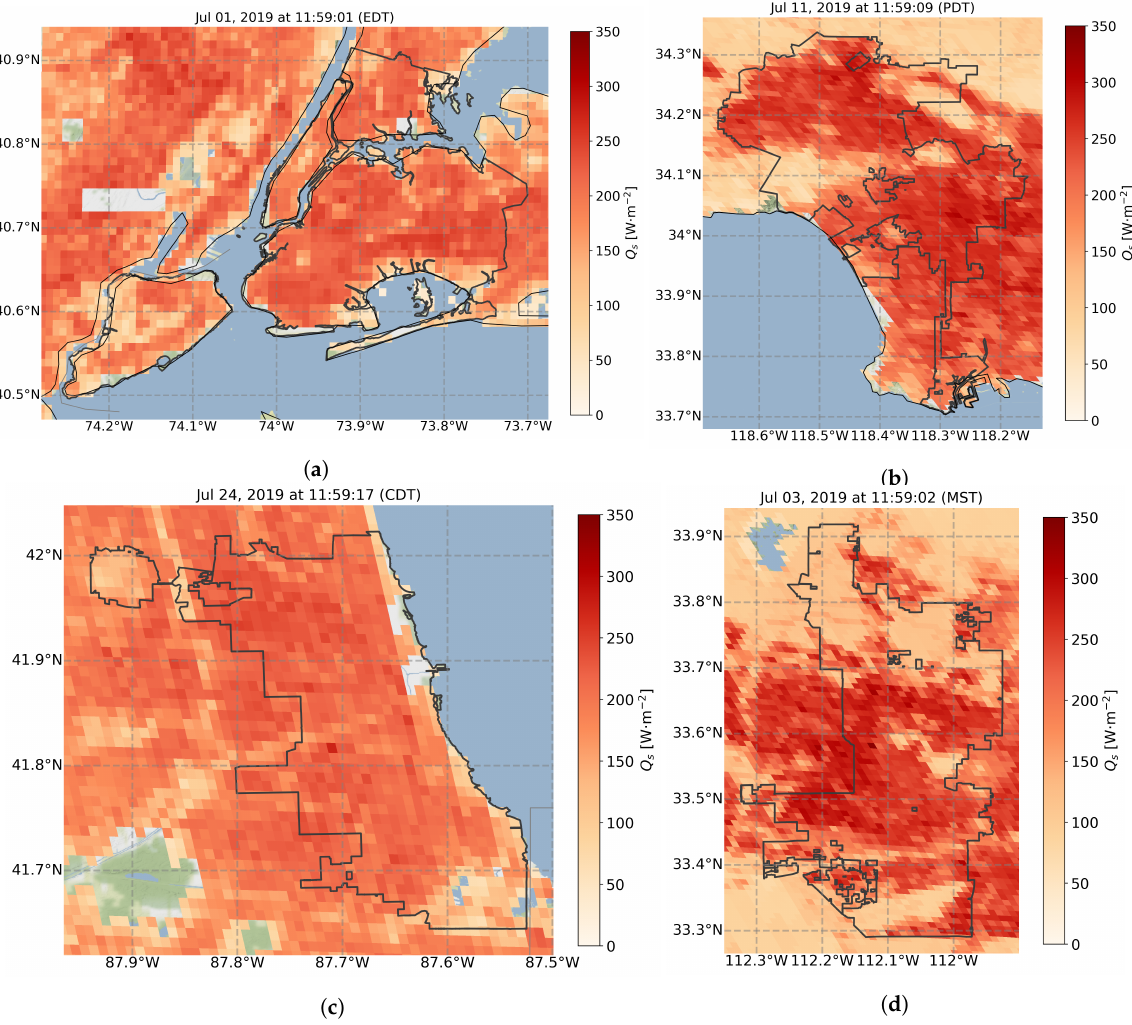
Figure 9. Spatial reconstruction of ∆ Q s under mostly clear daytime skies in July 2019 across four cities: ( a ) New York City; ( b ) Los Angeles; ( c ) Chicago; and ( d )